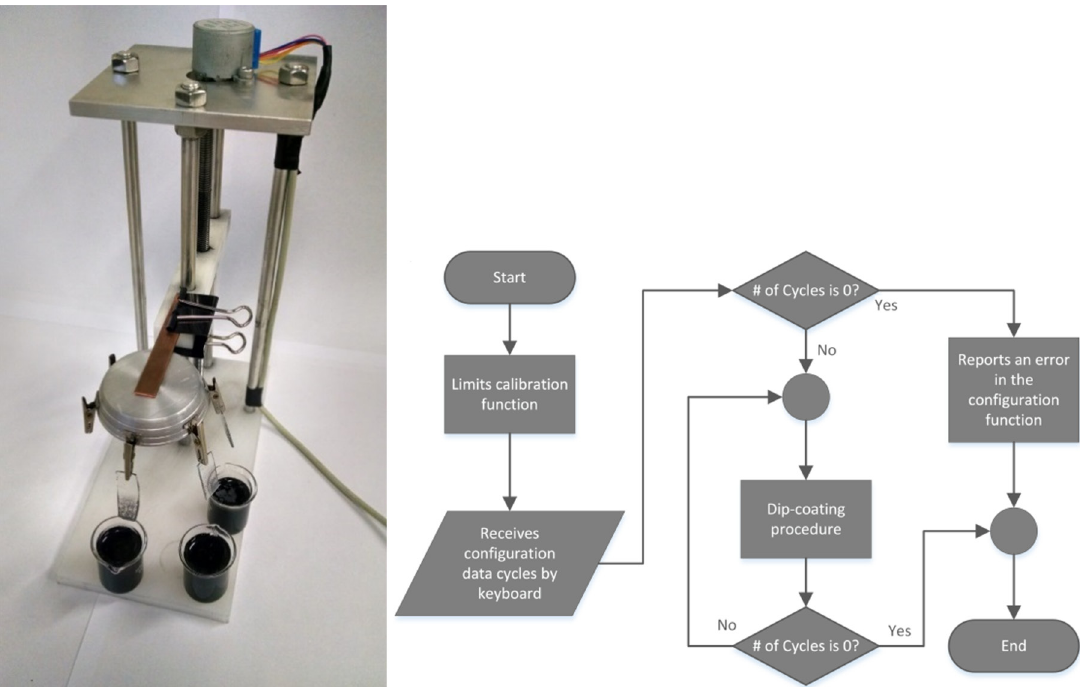
Figure 1. Dip coating mechanical device picture and block diagram of the routine for the